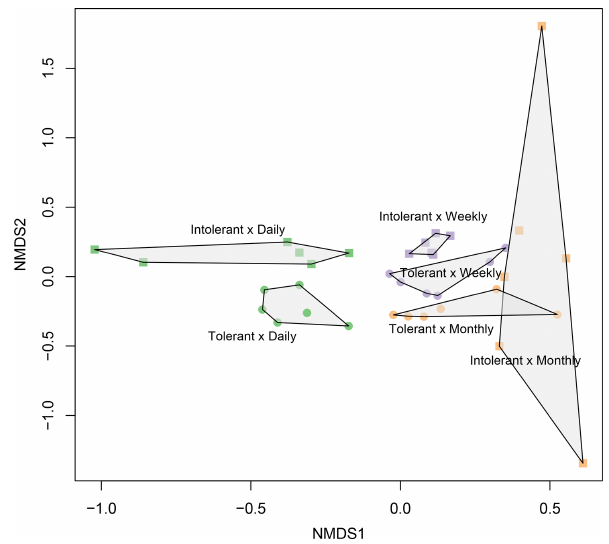
Figure 5. NMDS plot showing prokaryotic (bacterial and archaeal) community composition in soils planted with intolerant and toler- ant plant genotypes of Elymus athericus exposed to three different flooding frequencies (monthly, weekly, and daily). Plot shows all technical replicates (i.e., two samples from n = 3 mesocosms; vari- ability in technical replicates is illustrated in Fig. S1). For PER- MANOVA analyses, data from technical replicates were